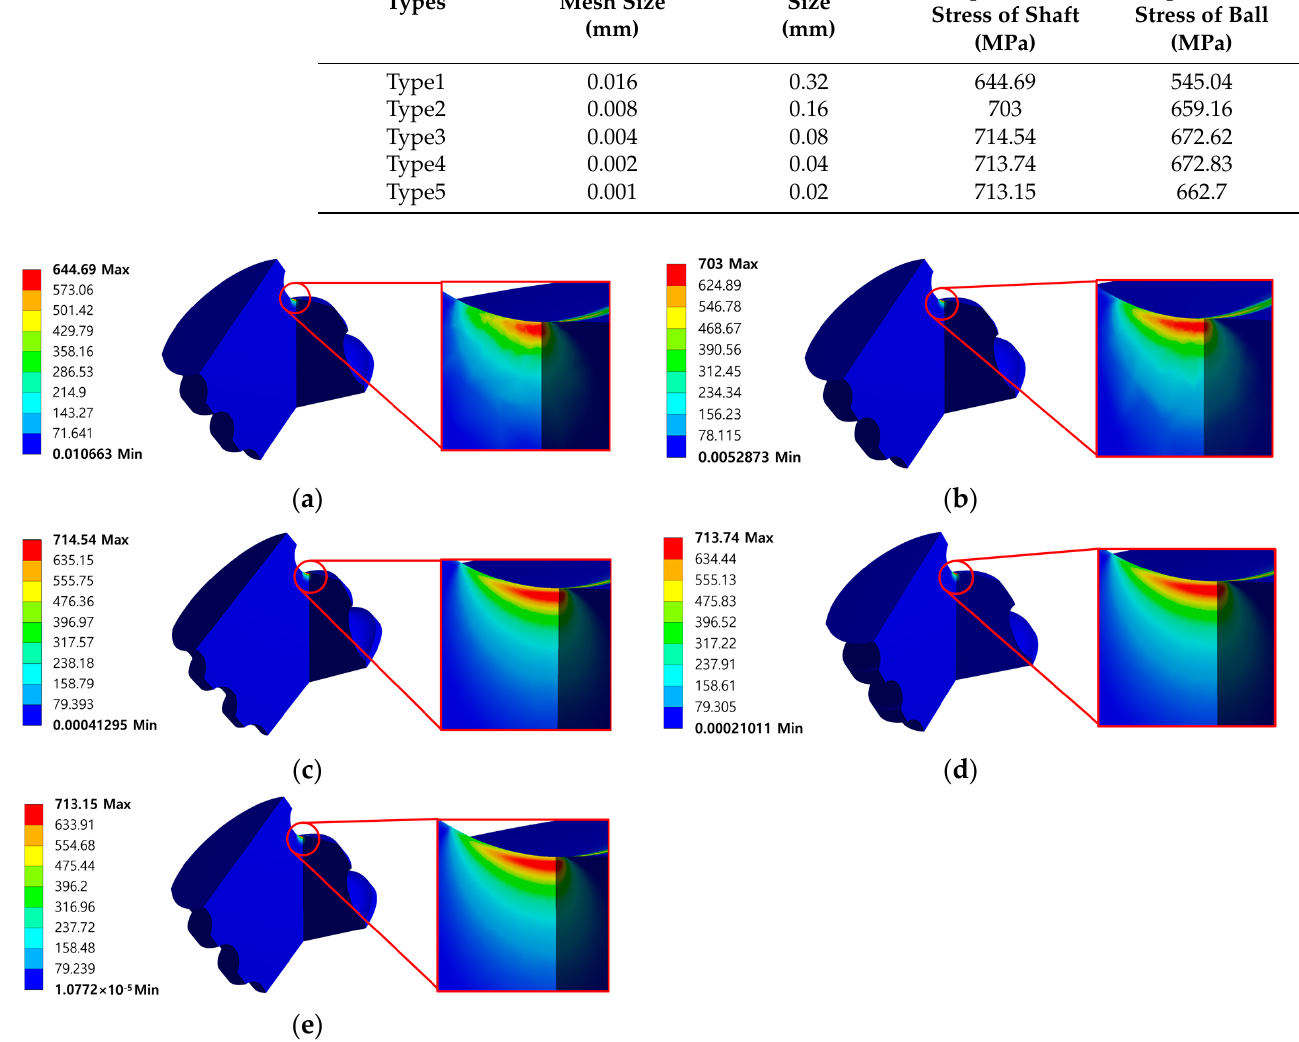
Figure 8. Equivalent stress (MPa) results of contact theory based model (shaft): ( a ) Type1; ( b ) Type2; ( c ) Type3; ( d ) Type4; and ( e ) Type5.